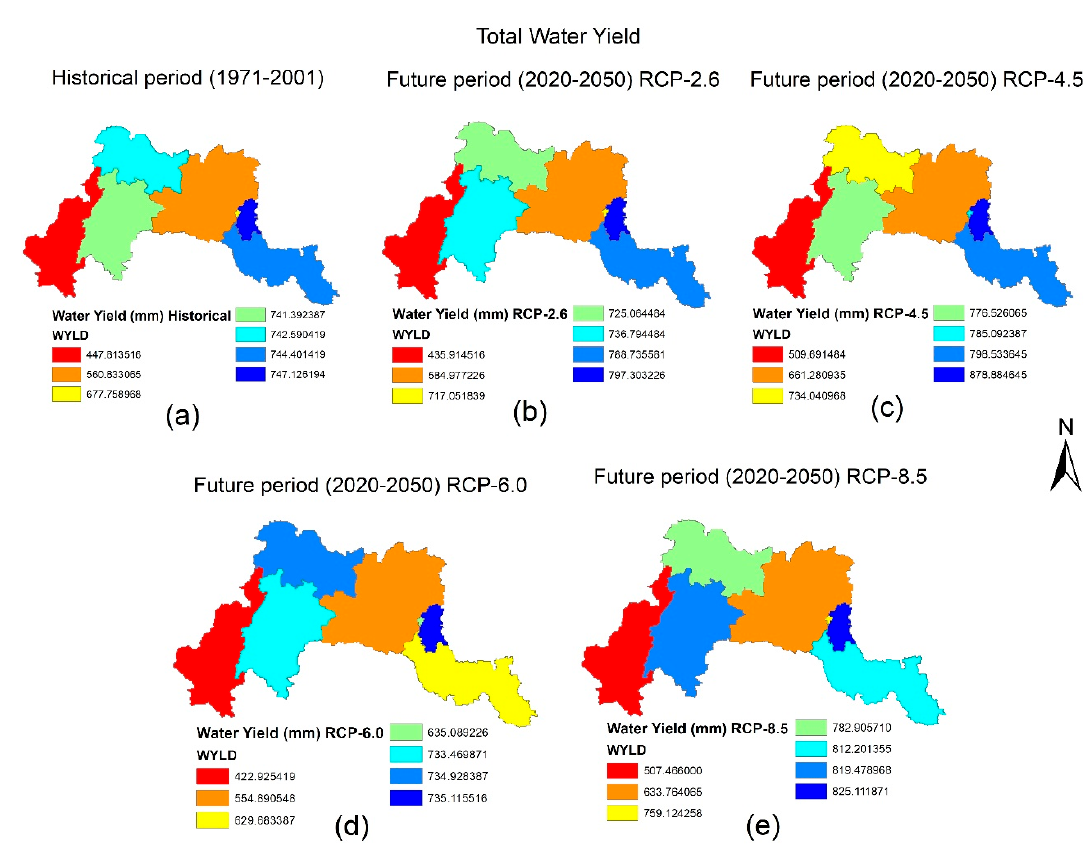
Figure 9. Water yield simulated by model under historical and future scenarios: ( a )